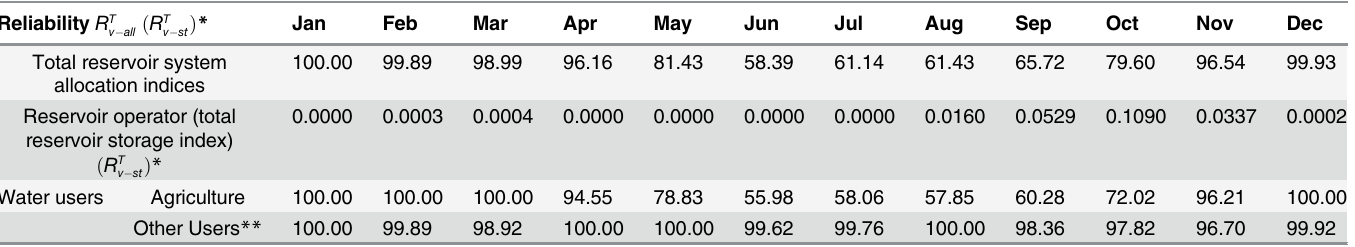
Table 6. Volumetric reliabilities of the reservoir system resulting from the simulation based on the presented method.